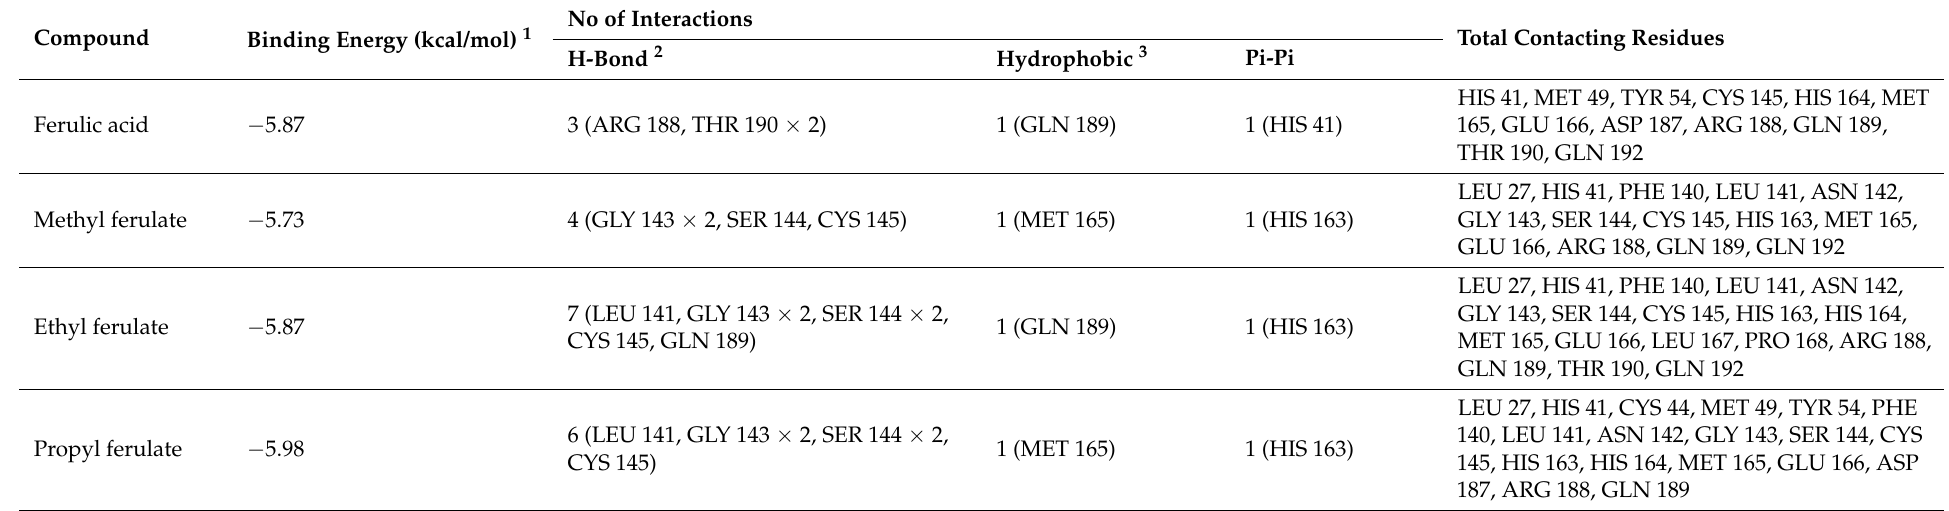
Table 2. Molecular docking simulation results for FA and its enzymatically synthesized